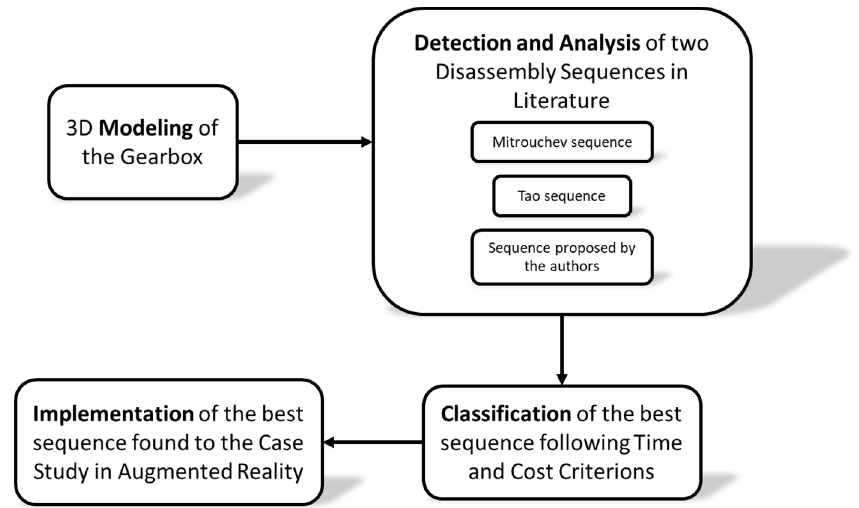
Figure 1. Structure of the paper.